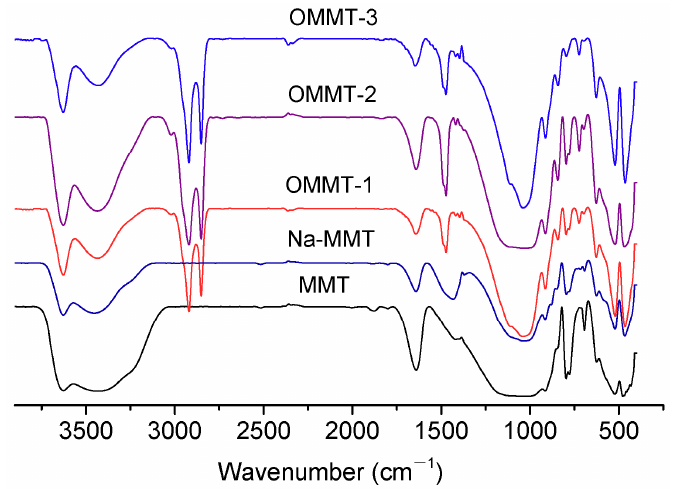
Figure 5. Fourier transform infrared (FTIR) spectra of the montmorillonite (MMT), Na-MMT, OMMT-1, OMMT-2, and OMMT-3 samples.